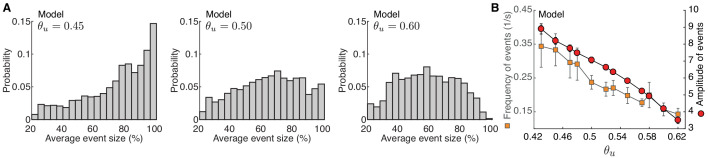
Developmental event sparsification in the model. (A) Distribution of spontaneous event sizes for the different input thresholds in the model as Figure 7D. (B) Frequencies (squares) and amplitudes (circles) of events with greater than 80% participation rate in the model at different input thresholds (abscissa). These events are suppressed both in amplitude and frequency at higher input threshold θu. Error bars represent the standard deviation of 10 simulations.